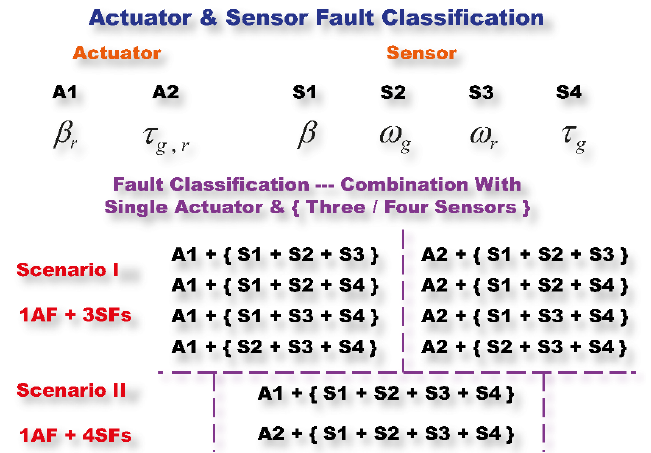
Figure 6. Experimentation design for actuator and sensor fault classification, under Scenario I (1AF + 3SFs) and Scenario II (1AF + 4SFs).